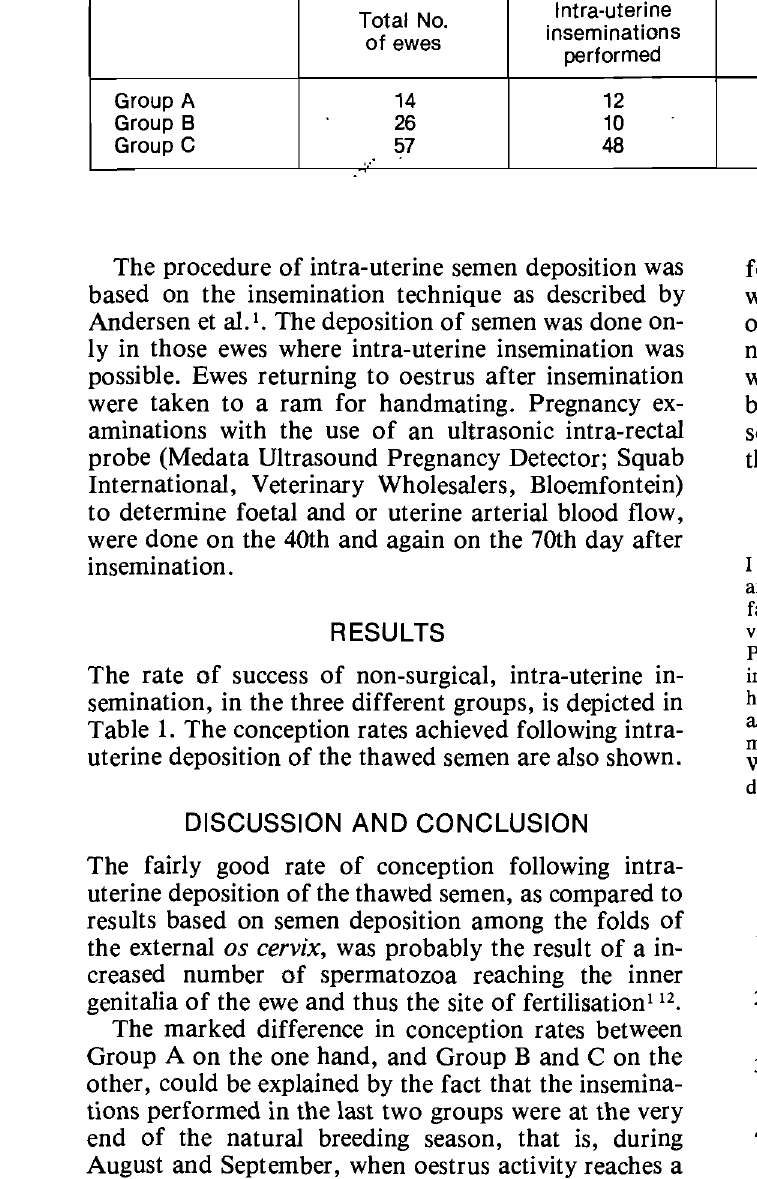
Table 1: THE RATE OF SUCCESSFUL INTRA-UTERINE INSEMINATIONS AND CONCEPTIONS IN THREE GROUPS OF EWES Intra·uterine Total No. of ewes Group